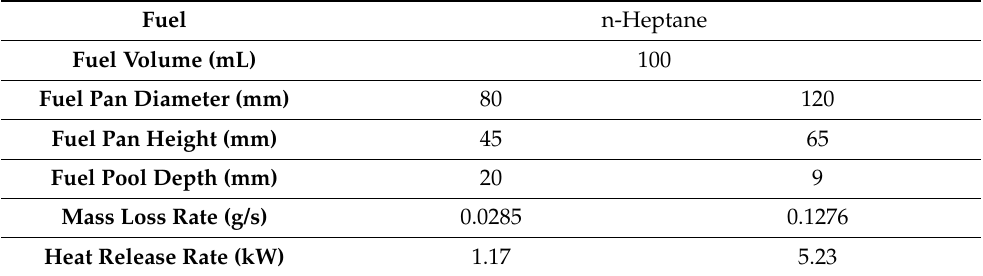
Table 2. Summary of fire